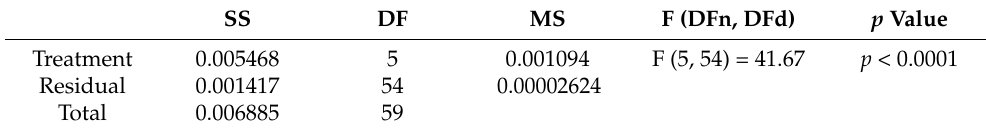
Table 6. ANOVA of the proposed feature selection method based on the wind speed dataset.